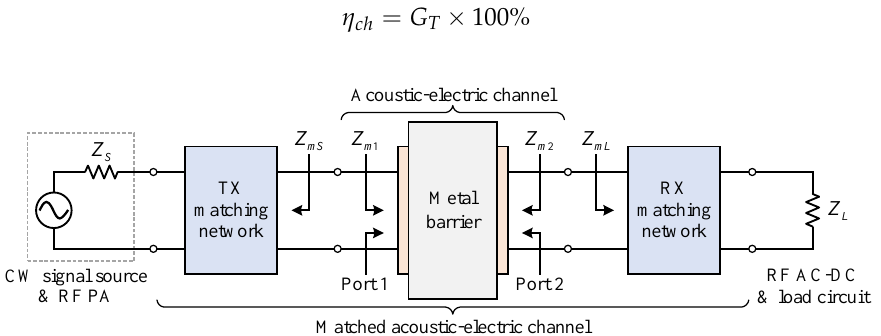
Figure 3. Simplified model of the impedance matched acoustic-electric